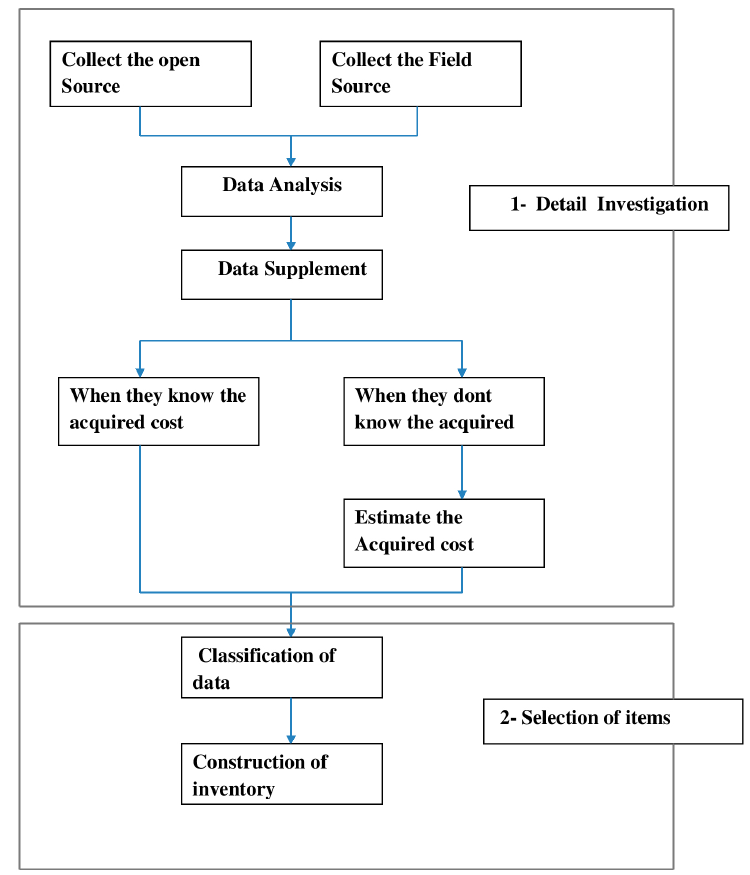
Figure 1. Flow chart for the construction of the inventory.